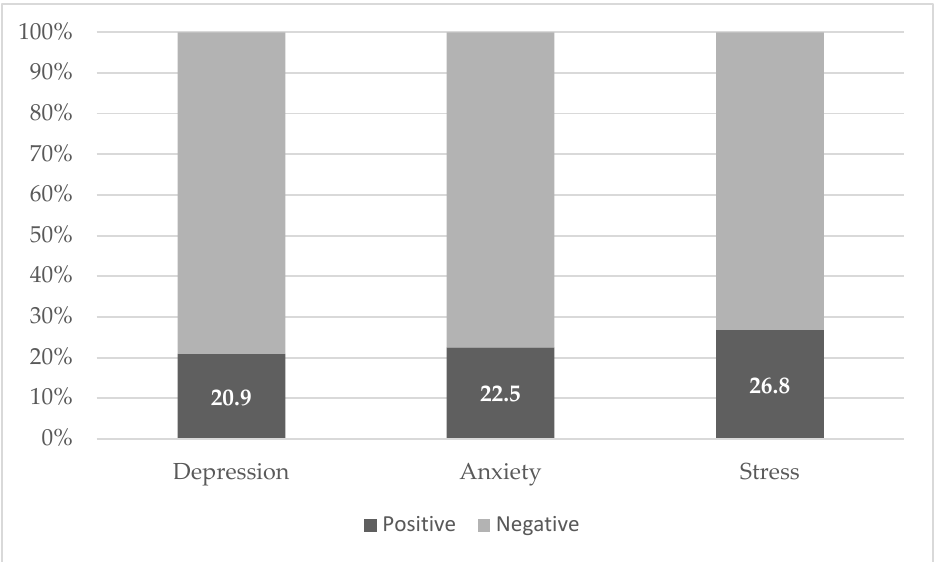
Figure 2. Psychometric assessment. Table 2. Statistically significant associations with the psychometric results (univariate